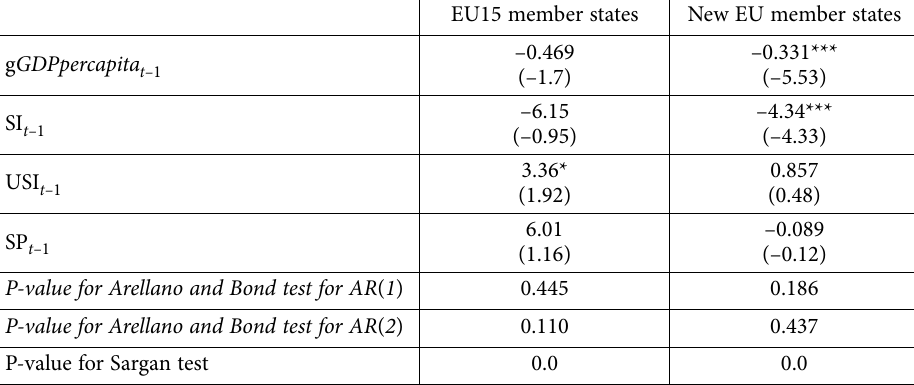
Table 4. Testing the impact of skilled and unskilled immigration on growth based on a dynamic panel model 1 for EU15 and the new EU member states (source: Author own